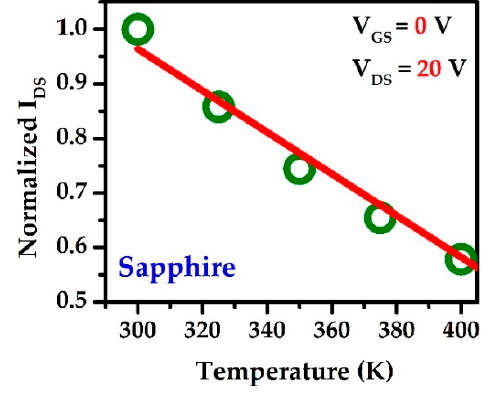
Figure 3. Temperature dependence of drain current at high V DS value.